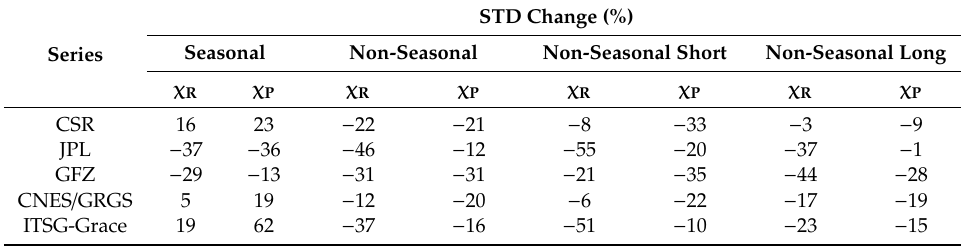
Table 2. The change of STD for HAM from new GRACE solutions compared with HAM from the older GRACE solutions.